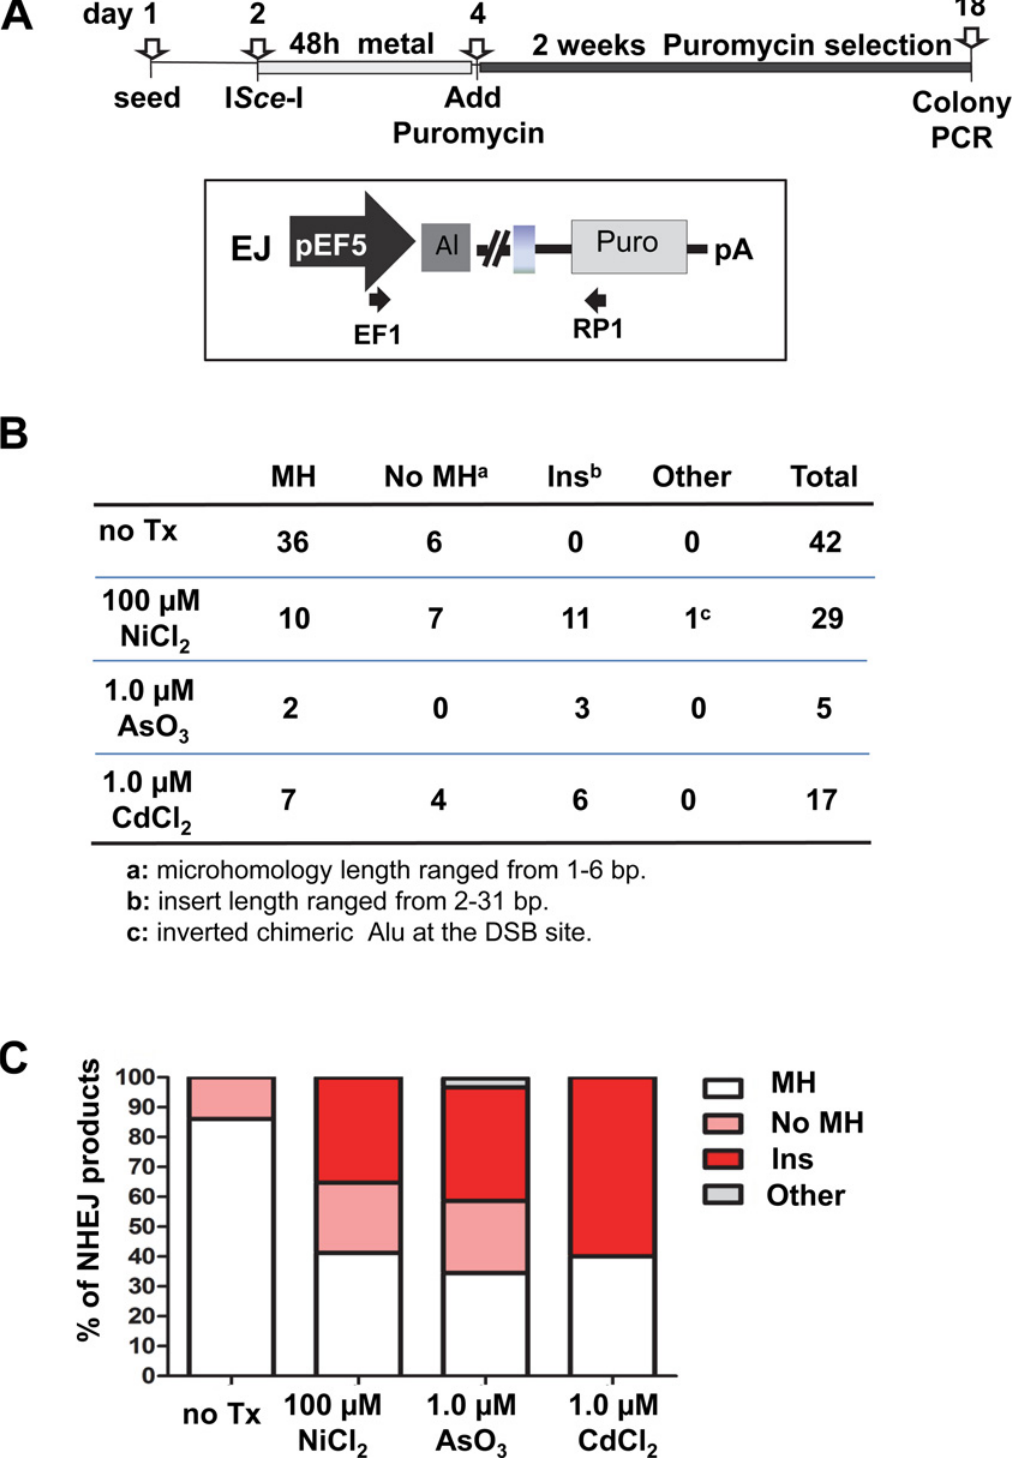
Fig 5. Heavy metal exposure alters the sequence characteristics of EJ DSB repair outcomes. A. A schematic of the protocol of the time line of the assay is shown. B. Table showing the number of recovered events classified as end-joining products of I- Sce I induced breaks of cells exposed to: